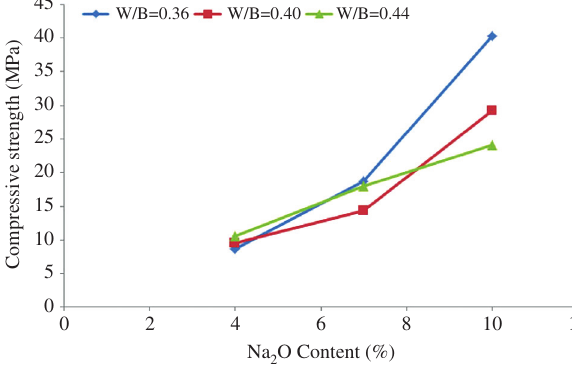
Figure 14 The effect of aging on geopolymer compressive strength for samples cured at 45 ° C.